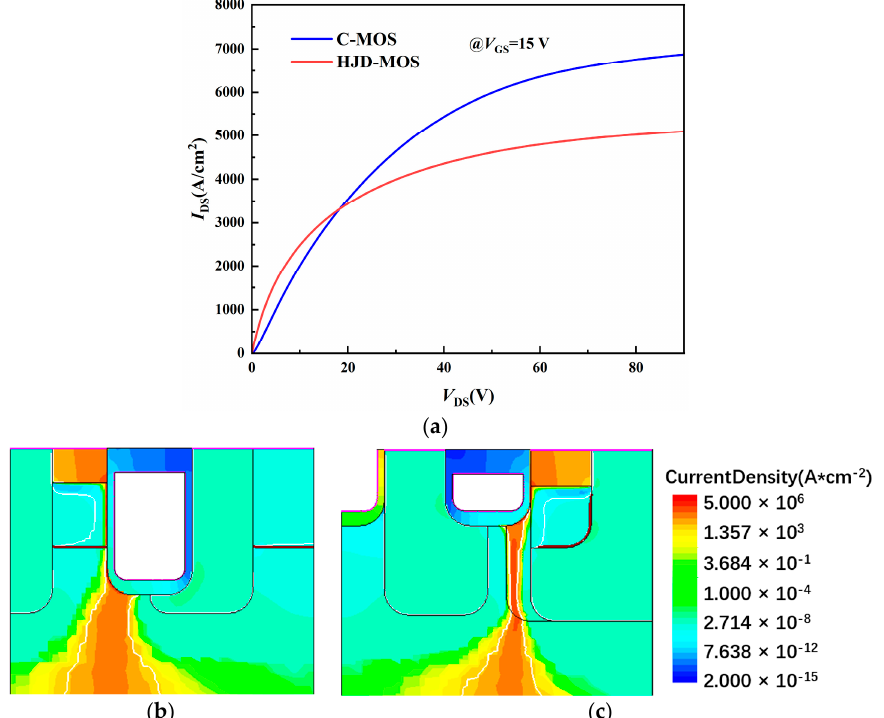
Figure 5. The ( a ) first quadrant I-V characteristics of the C-MOS and the proposed structure and the current path of ( b ) C-MOS and ( c ) proposed structure.